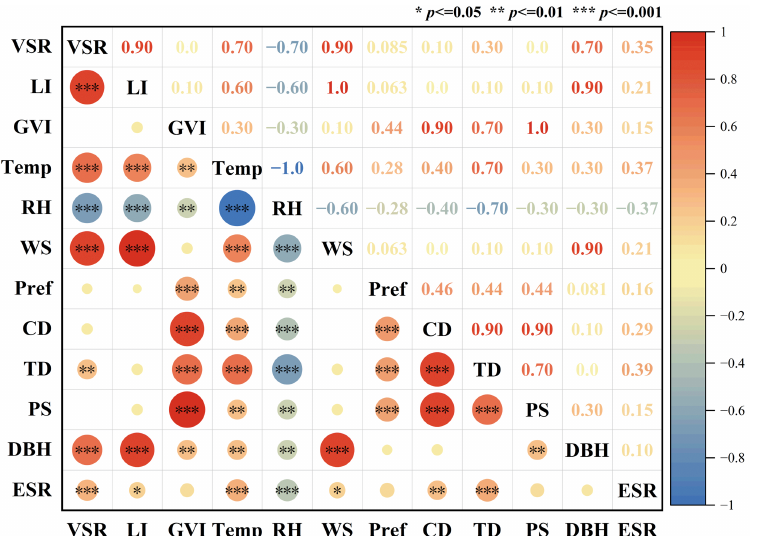
Figure 5. Spearman correlation matrix showing the relationships between environmental factors and eye strain recovery. Red and blue colors denote positive and negative correlations, respectively; intensity of color reflects the strength of the